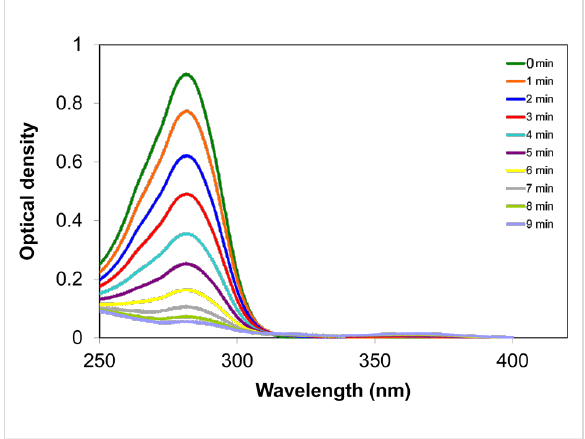
Figure 3: Decrease of the UV absorption band of compound 1 under irradiation (254 nm) in air-saturated CHCl 3 , c = 5 × 10 − 5 M.